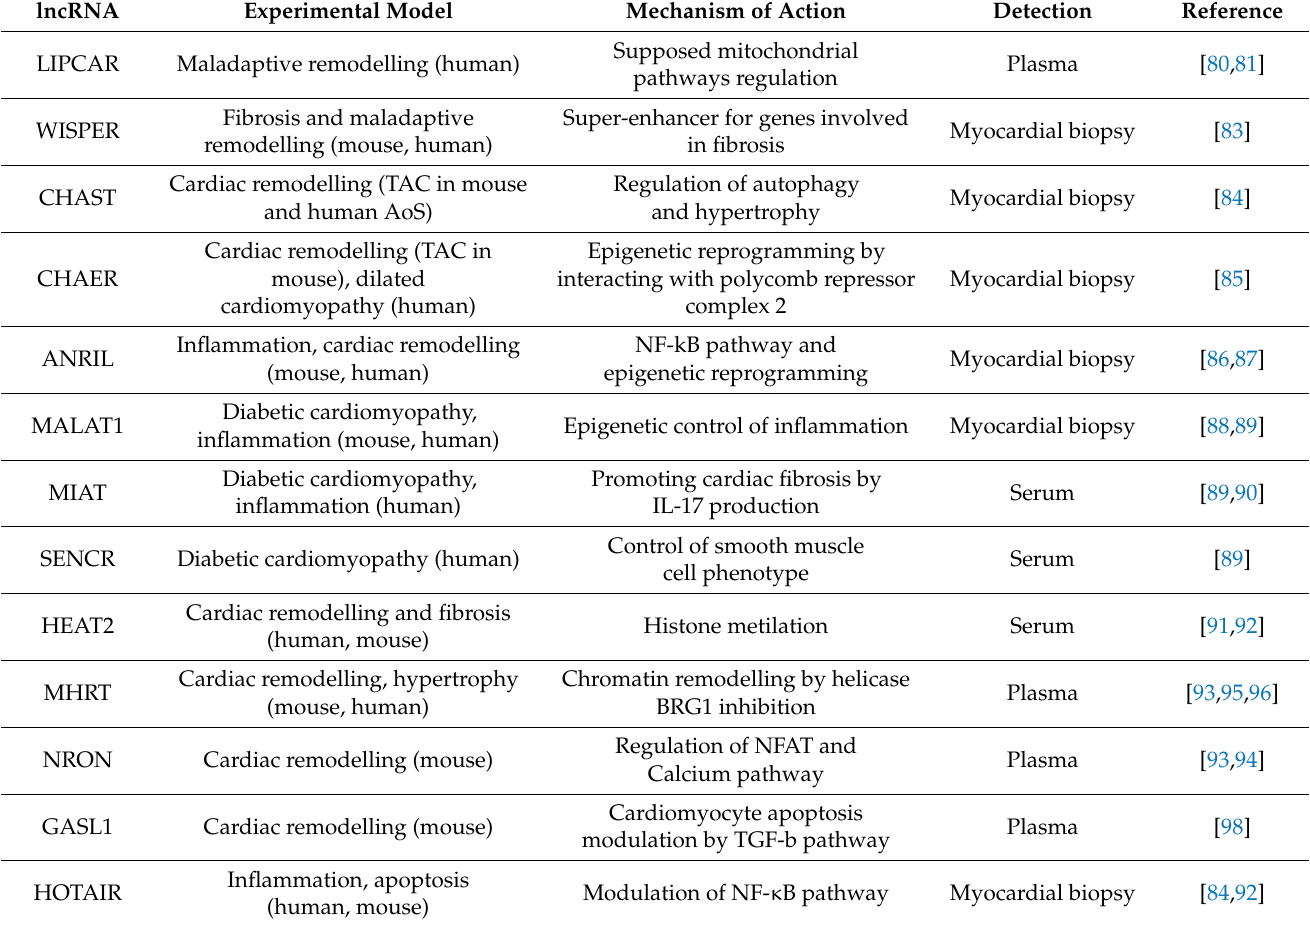
Table 2. Long noncoding RNA in